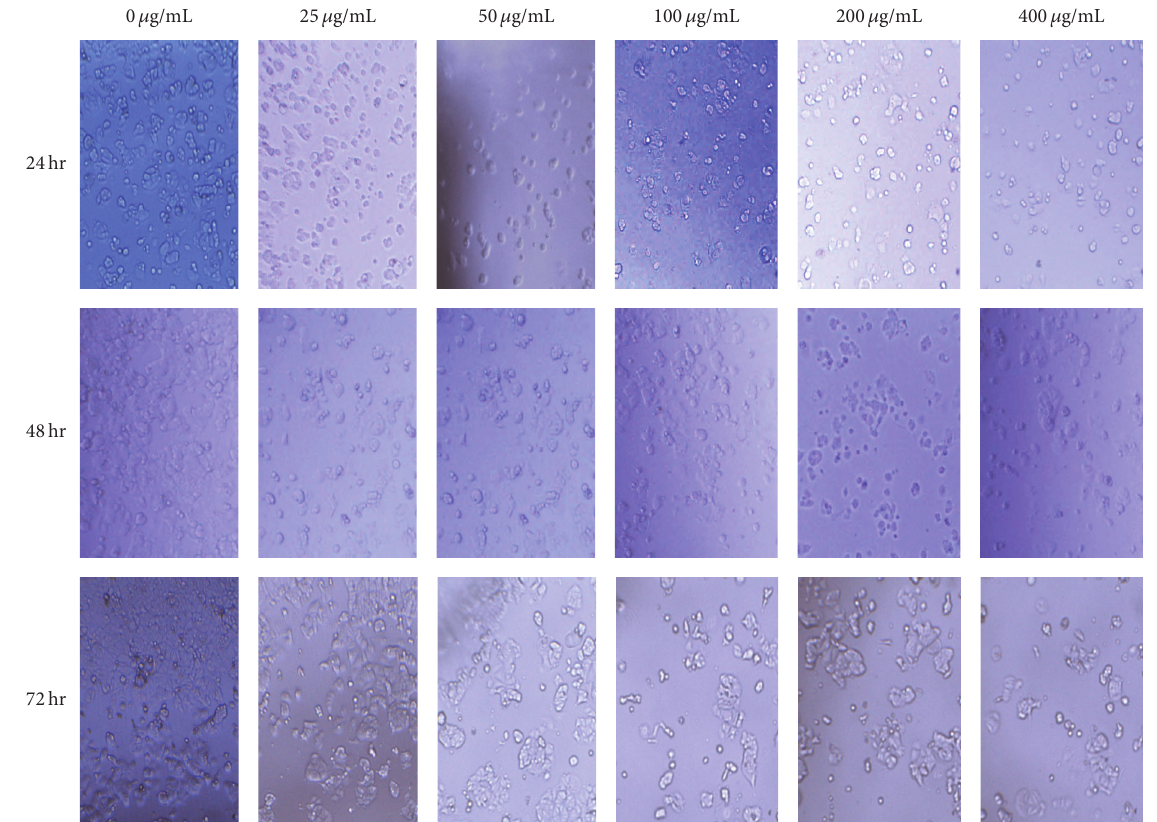
Figure 7: Morphology of human breast cancer cells (MCF-7), after 24, 48, and 72 hr incubating with the [Re(CO) 3 (N(SO 2 pip)dpa)] + complex at increasing